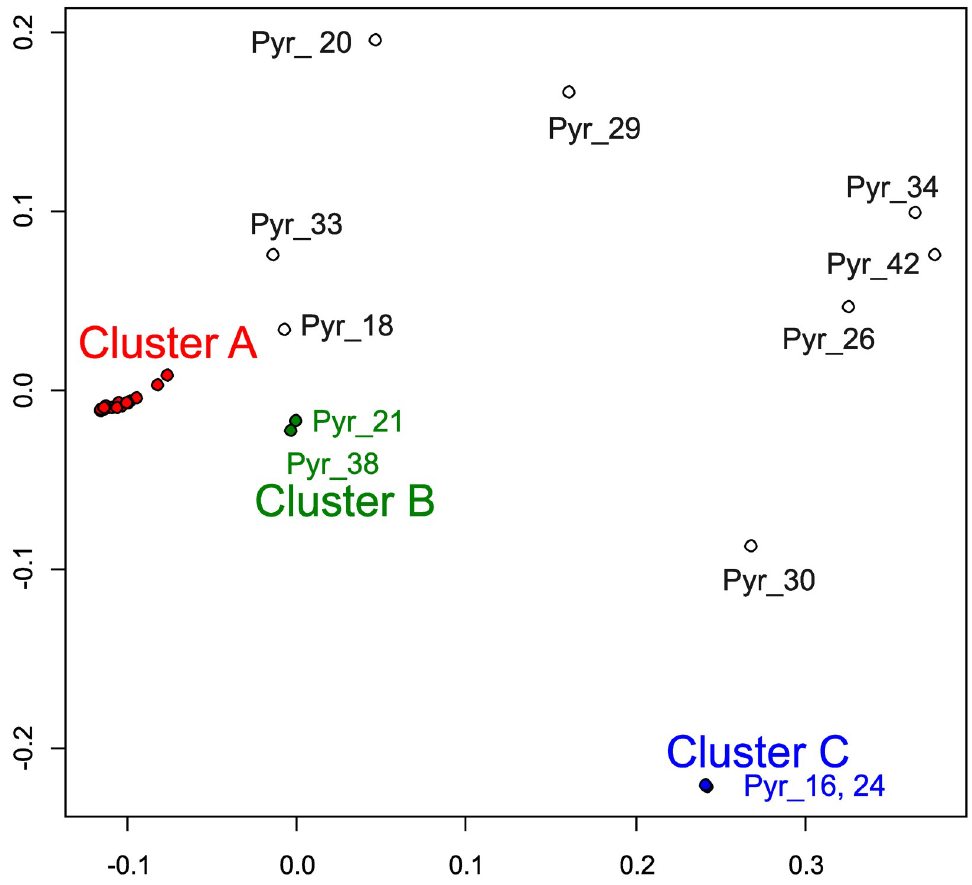
Fig 5. Multidimensional scaling representation using nuclear DNA data of 31 Pyropia yezoensis samples. Two- dimensional data were obtained in this analysis. Colors were used to show 3 clusters, cluster A, B, and C, found in this